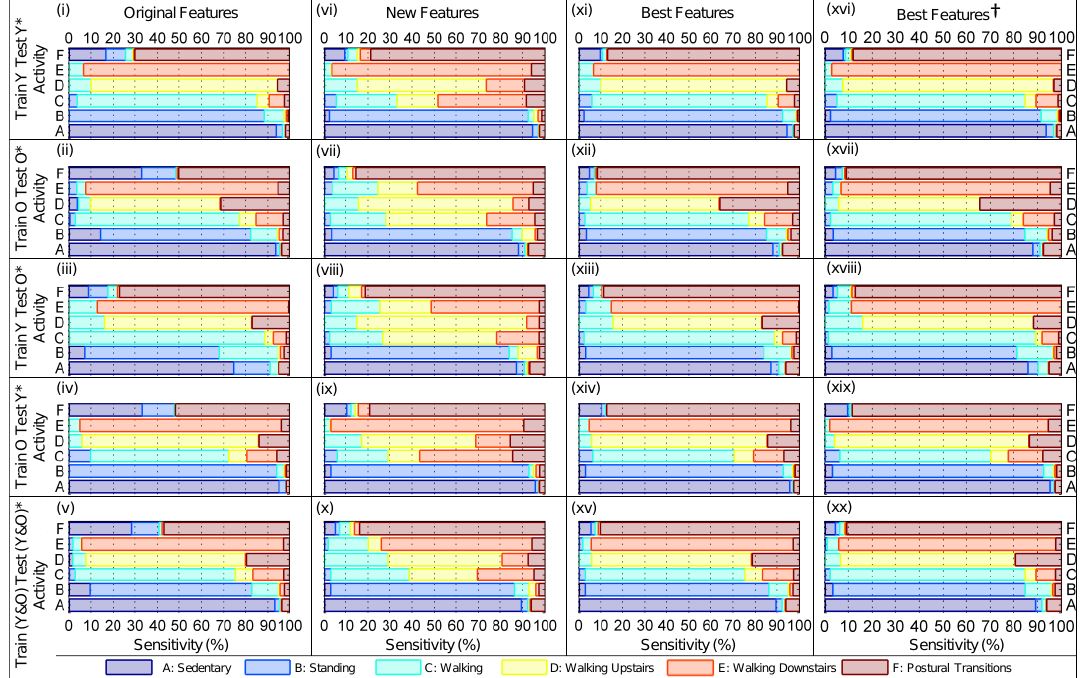
Figure 10. The column titled: ‘Original Features’ (i.e., panels ( i – v )) correspond to hierarchical models of human activity that were trained and tested with the features developed in our previous Features’ (i.e., panels ( v i– x )) correspond to hierarchical models of human activity that were